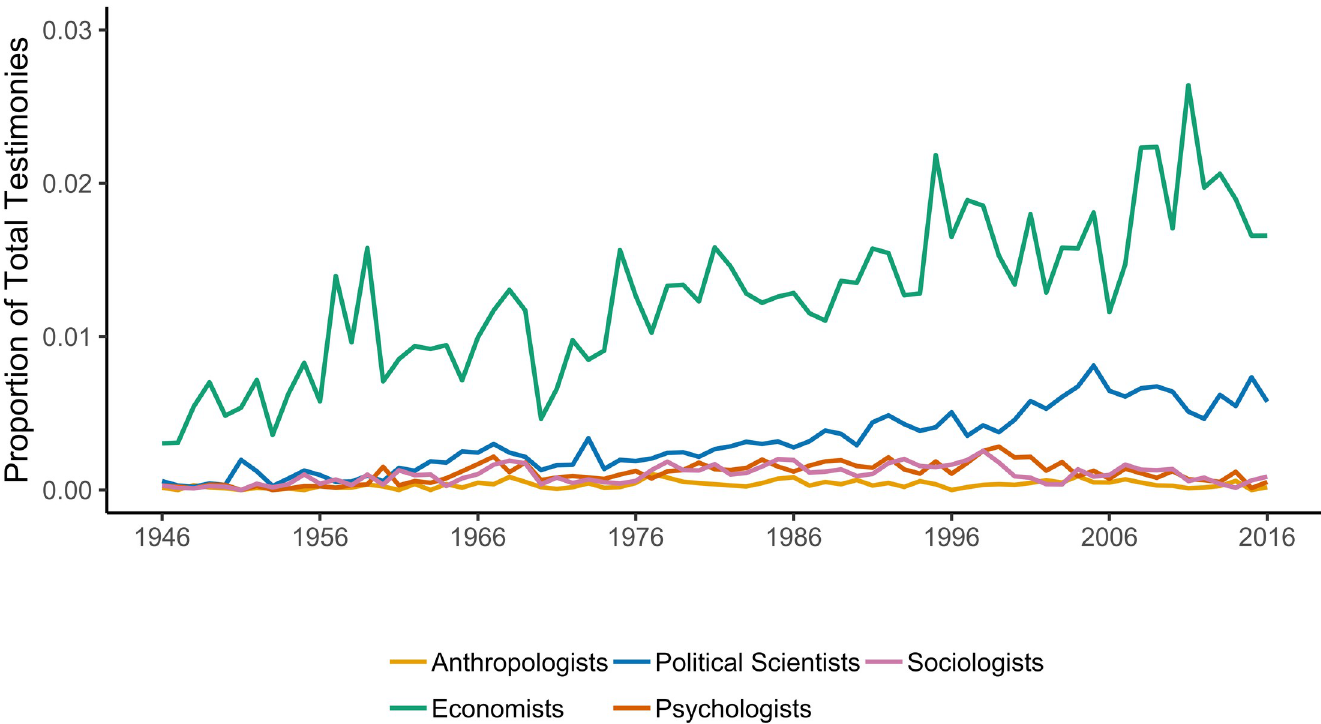
Fig 3. Social scientists as proportion of all testimony.